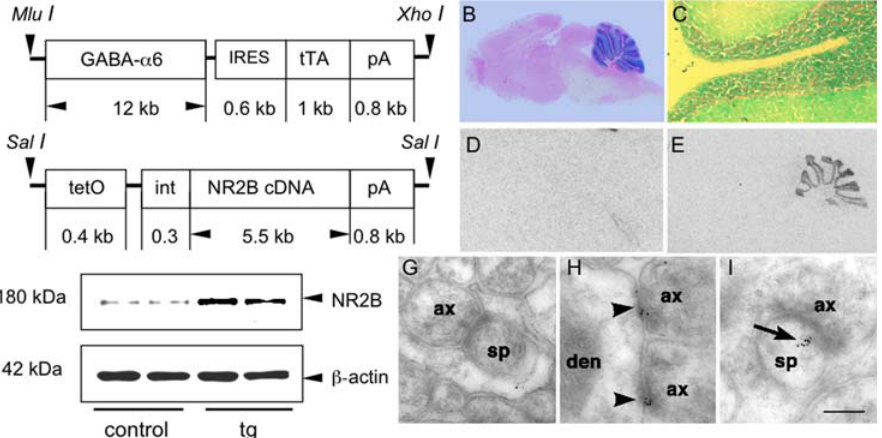
Figure 1. Inducible cerebellar granule cell-specific NR2B transgenic mice. A. Expression vectors for GABA- a 6-tTA (upper panel) and tetO- NR2B (low panel). pA: poly-A signal; int: artificial intron. B and C. Granule cell specific expression. LacZ staining reveals that blue stain is exclusively observed in the cerebellar cortex (B) and is restricted to granule cells only (C). D and E. Distribution of the NR2B transgene in the cerebellum. in situ hybridization shows that the expression of the NR2B transgene is exclusively observed in the cerebellar cortex of tg (E), but not of control mice (D). F. Expression level of the NR2B transgene. Western blot shows the expression of NR2B protein (180 kDa) in the cerebella of tg mice, but not of control (cont) mice. ß-actin blot (42 kDa) shows the relative amount of protein loading. G–I. Synaptic localization of NR2B protein. EM immunocytochemistry shows positive gold-particles in many mossy fiber/granule cell synapses of tg (H and I), but not of control mice (G). The immunoreactivity in tg mice is associated within the ‘‘active zone’’ (postsynaptic density and synaptic cleft, arrow heads) of the synapse (H; arrowhead) or is associated throughout the spinous cytoplasmn and neuropil of spine head (I; arrow). ax: axon; den: dendrite; sp: spine. Scale bars in I=0.3 m m.